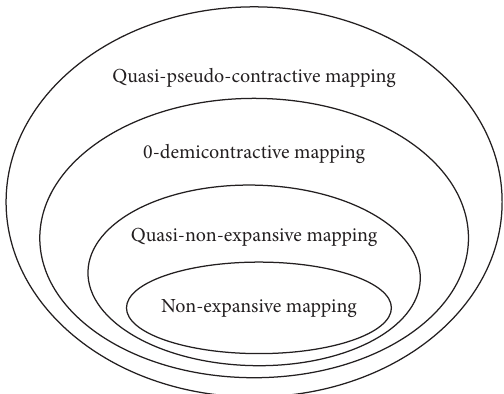
Figure 7: The relations of some nonlinear